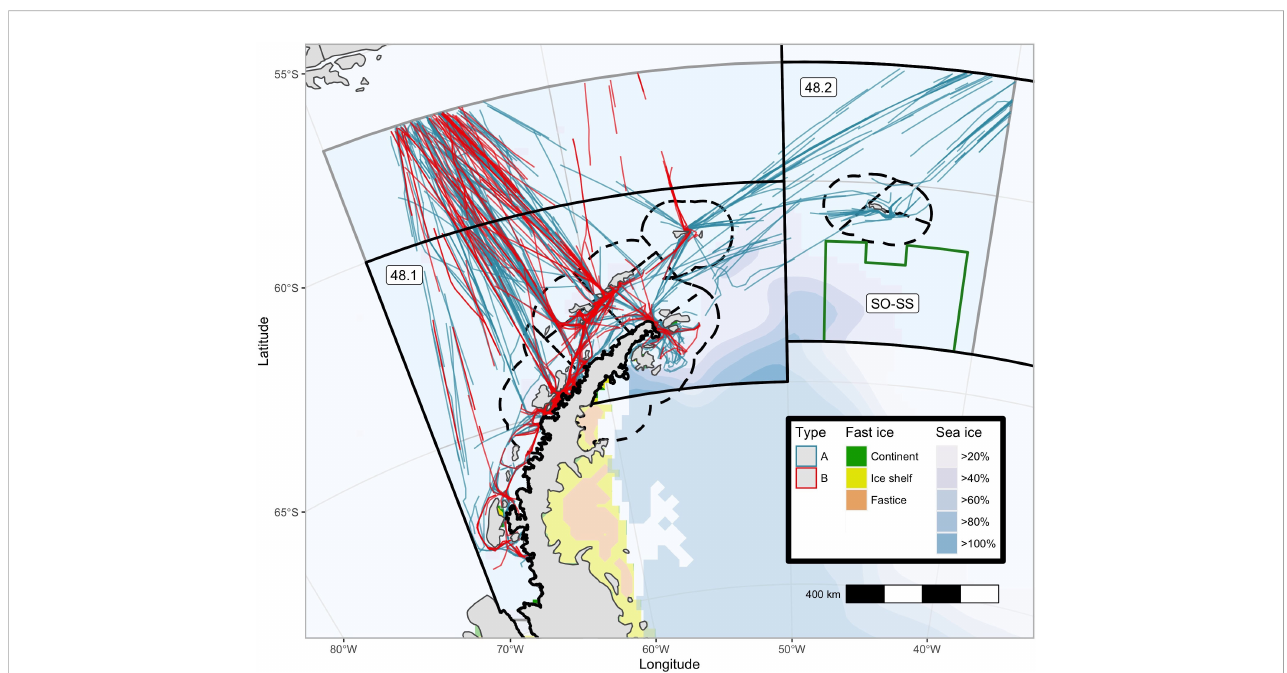
FIGURE 1 Potential survey effort from a portion of the tourist vessels that tour the southwest Atlantic Ocean (November-March). Modi fi ed tourist vessel tracks from 29 of the 45 vessels which toured the southwest Atlantic Ocean in the 2019/20 Antarctic summer tourist season. CCAMLR Management regions Subarea 48.1 and.2 (solid black lines), Small Scale Management Units (dash black lines), and the south Orkney Island Southern Shelf MPA (green line) are plotted. The two basic tourist vessel itineraries are plotted, type (A, B) Sea Ice (extracted from the National Snow and Ice Data Centre via R Package ‘ raadtools ’ ) and Fast Ice (Fraser et al., 2020) are as of March